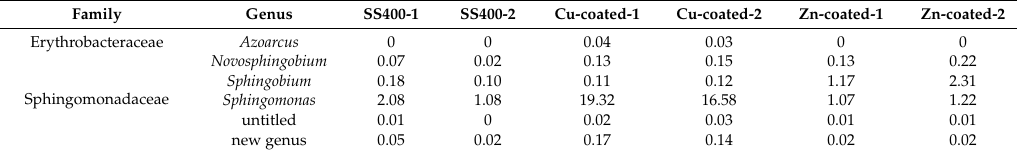
Table 4. The OTU percentages of MIC-related bacteria on post water-immersed coupons. Family Table 3. The OTU percentages of order Sphingomonadales on post LBR-immersed coupons. SS400- Family Genus Erythrobacteraceae Azoarcus Sphingomonadaceae